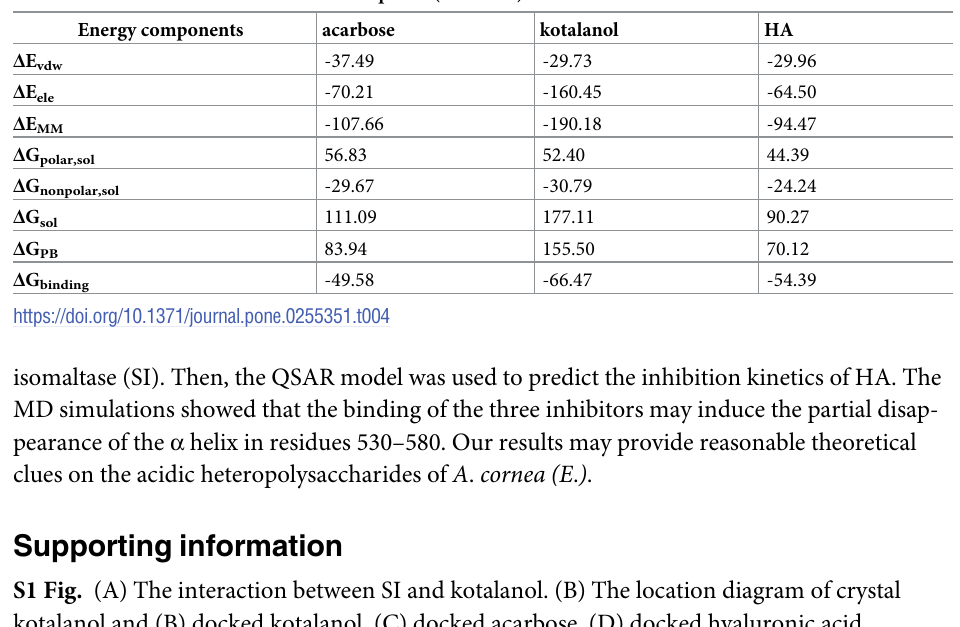
S1 Fig. (A) The interaction between SI and kotalanol. (B) The location diagram of crystal kotalanol and (B) docked kotalanol, (C) docked acarbose. (D) docked hyaluronic acid. (TIF)